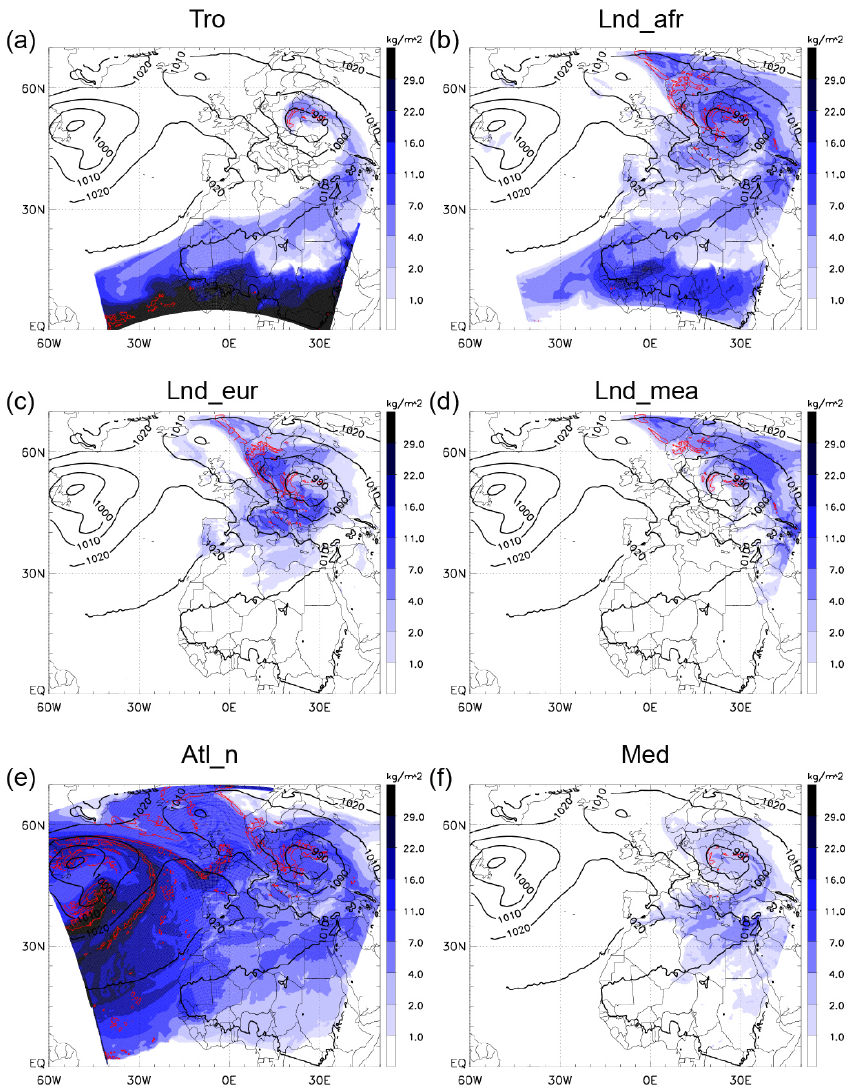
Figure 6. Vertically integrated tagged water vapour (kgm − 2 , blue shading) and vertically integrated tagged cloud water (red contour of 0.1kgm − 2 ) from sources (a) Tro, (b) Lnd_afr, (c) Lnd_eur, (d) Lnd_mea, (e) Atl_n and (f) Med and sea level pressure (black contours every 10hPa) at 12:00UTC on 16 May